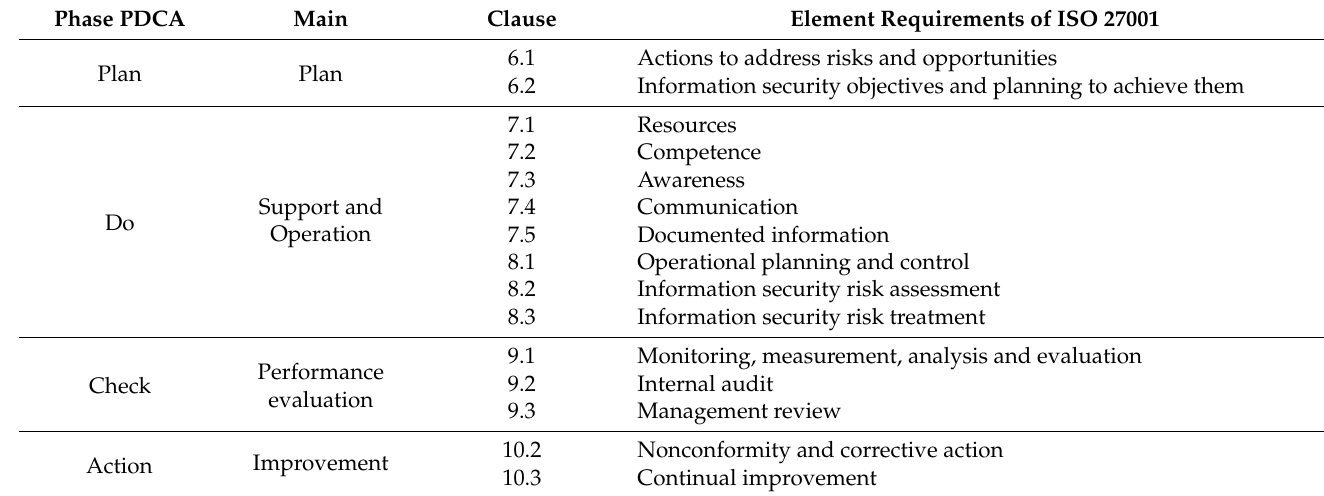
Table 1. PDCA Framework and Element Requirements of ISO 27001 (ISO/IEC 27001:2013 2013).